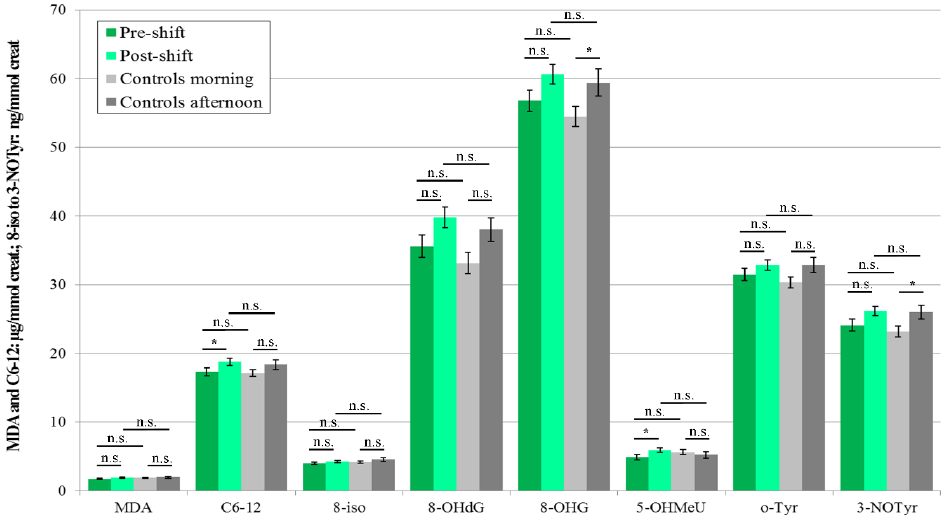
Figure 6. Mean and standard deviation of the levels of eight oxidative stress markers in the urine of 21 workers (shift = welding or machining) and 18 control subjects in 2018, * p < 0.05, n.s. = not significantly different, creat. = creatinine, MDA = malondialdehyde, C6-12 = aldehydes C6-C12, 8-iso = 8- iso -prostaglandin F2 α (8-isoprostane), 8-OHdG = 8-hydroxy-2-deoxyguanosine, 8-OHG = 8-hydroxyguanosine, 5-OHMeU = 5-hydroxymethyl uracil, o-Tyr = o -tyrosine, 3-NOTyr = 3-nitrotyrosine.